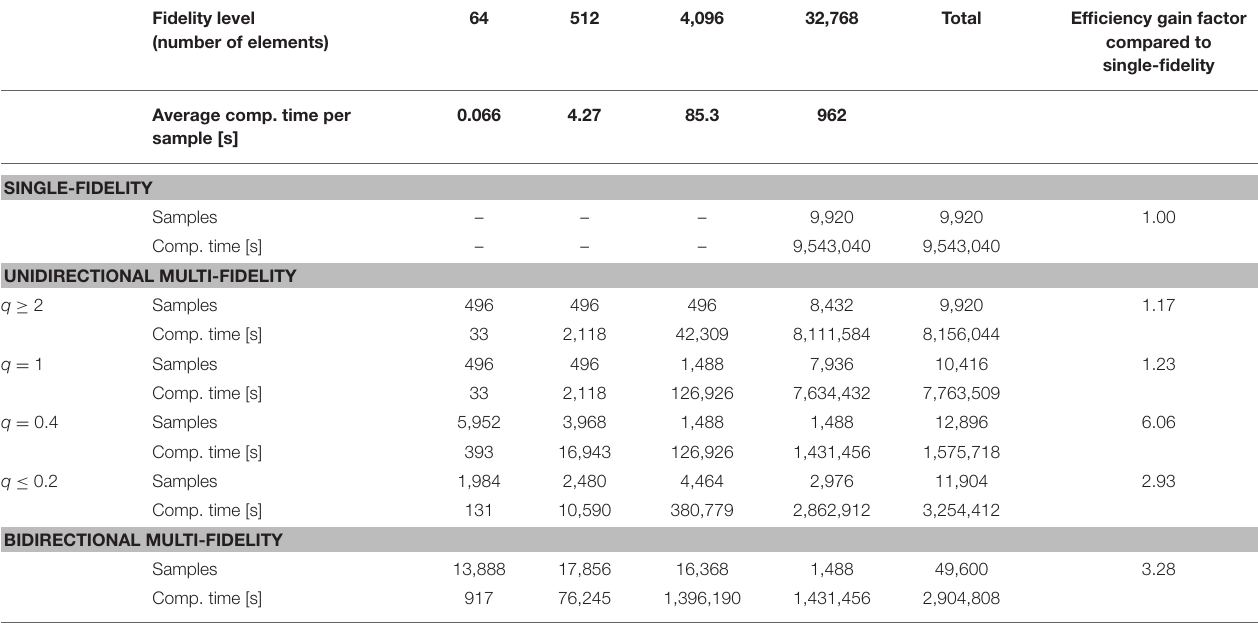
TABLE 5 | Computation times and sample numbers for different training strategies for the membrane problem from section “Two-dimensional problem: elastic deformation of a thin membrane under loading.” Fidelity level (number of